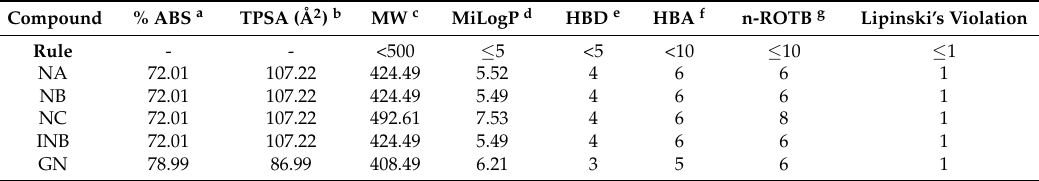
Table 3. Physicochemical properties of the compounds for good oral